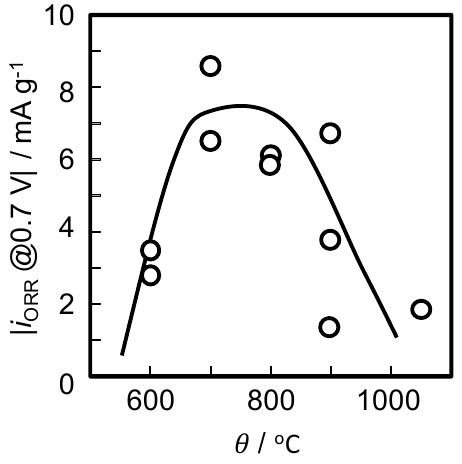
Figure 9. Dependence of i ORR @ 0.7 V on temperature used for heat-treatment of the samples under reductive